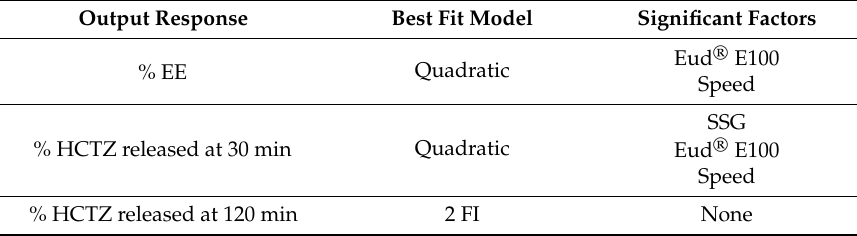
Table 3. Summary of outputs, the best fit models and significant input